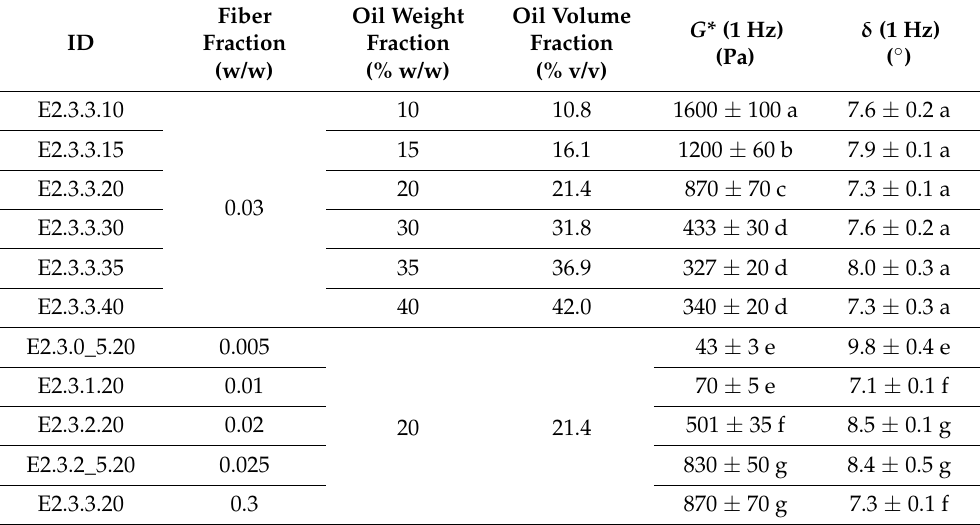
Table 3. Emulgels produced by varying either the fiber fraction or the fraction of dispersed phase (oil); mixing conditions fixed at E2 s = 45.2 J/g and P s = 0.151 W/g. G * is the complex modulus and δ is the phase angle. Different letters, for the same parameter and for the same set of samples, refer to significantly different